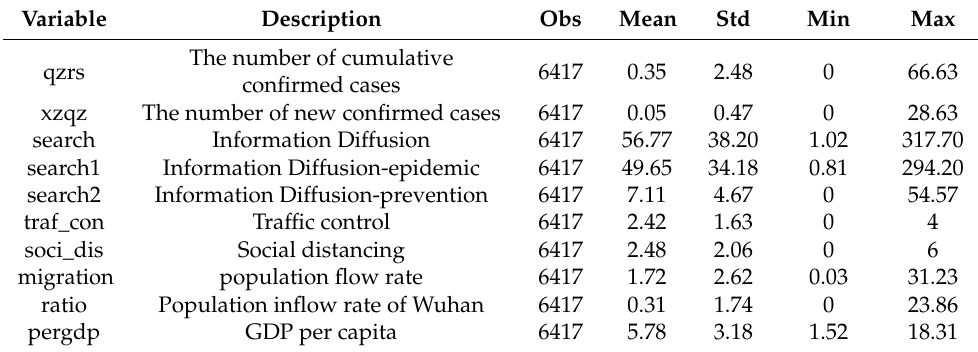
Table 3. Statistical description of